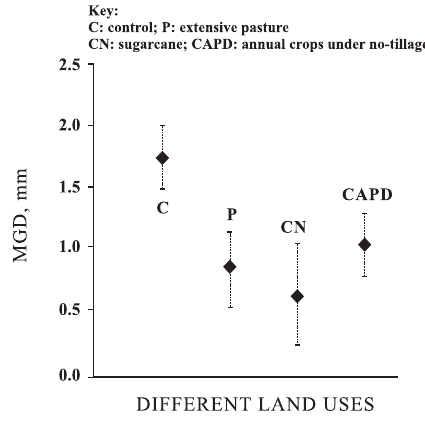
Figure 3. Mean values and confidence interval (95 %) for mean geometric diameter of soil aggregates (MGD), calculated for the 0–20 cm soil layer in areas of different land